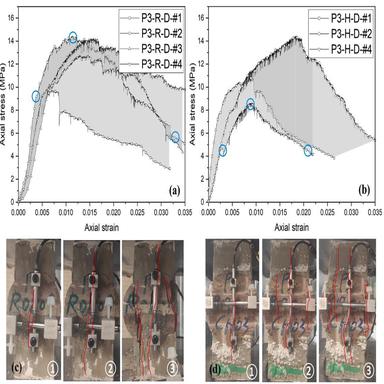
Axial stress versus axial strain under compression for double-wythe cores extracted from P3 with the random bond pattern (a) and the H-shaped bond pattern (b); the evolution of crack pattern for core P3-R-D-#2 (c) and P3-H-D-#4 (d).